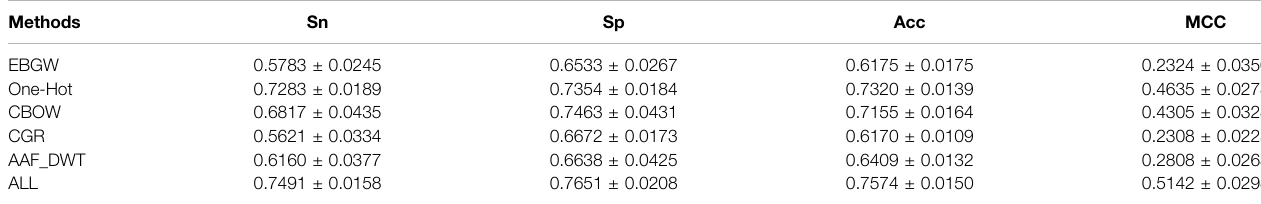
TABLE 3 | Performance comparison of different feature extraction methods on the training set according to ten-fold cross-validation based on the stacking ensemble classi fi er proposed in this study. Methods